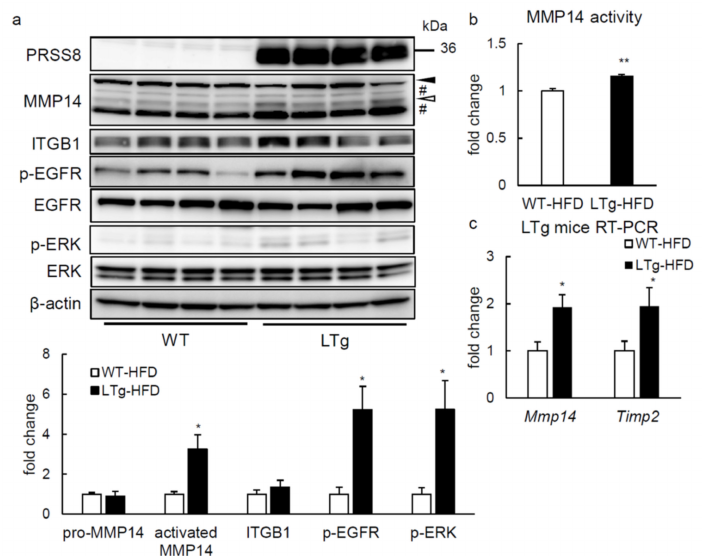
Figure 5. LTg mice activated MMP14 cascades similar to the Tet-on HepG2 cells. ( a ) Western blotting analysis and quantification of matrix metalloproteinase (MMP) 14 cascade in the liver of the WT/LTg mice under feeding HFD after overnight fast (14 h) (n = 4 per group). A solid arrowhead; pro- MMP14, an open arrowhead; activated MMP14, #; nonspecific bands. Phospho-EGFR and -ERK were normalized to total EGFR and ERK, respectively. Other proteins were normalized to β -actin. Values are shown as the mean ± SEM; * p -value < 0.05 ( t test). ( b ) The MMP14 activity of the liver of WT/LTg mice after overnight fast (14 h) was measured (n = 4 per group). Values are shown as the mean ± SEM; ** p -value < 0.01 ( t test). ( c ) RT-PCR of MMP14 and tissue inhibitor of metalloprotease (TIMP) 2 genes in the liver of the WT/LTg mice under feeding HFD after overnight fast (14 h) (n = 5–6 per group). Values are shown as the mean ± SEM; * p -value < 0.05 ( t test).